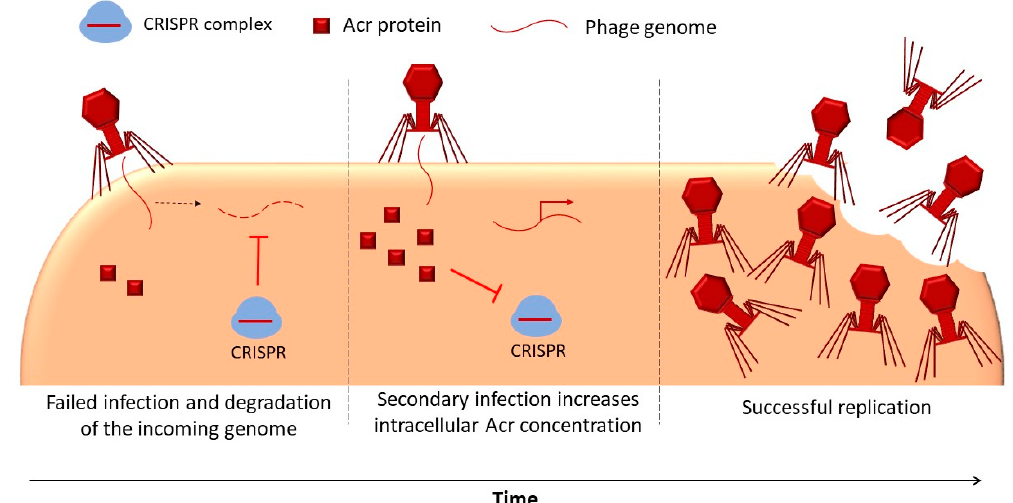
Figure 2. Anti-CRISPR proteins as an intracellular public good. A first (altruistic) virus expresses Acr proteins, but these are not sufficient to inactivate the CRISPR system, leading to degradation of the viral genome and abortive infection. However, the cell remains in a transient immunosuppressed state due to the action of the Acr proteins, which allows a second (potentially identical) virus to overcome CRISPR and successfully complete the infection.